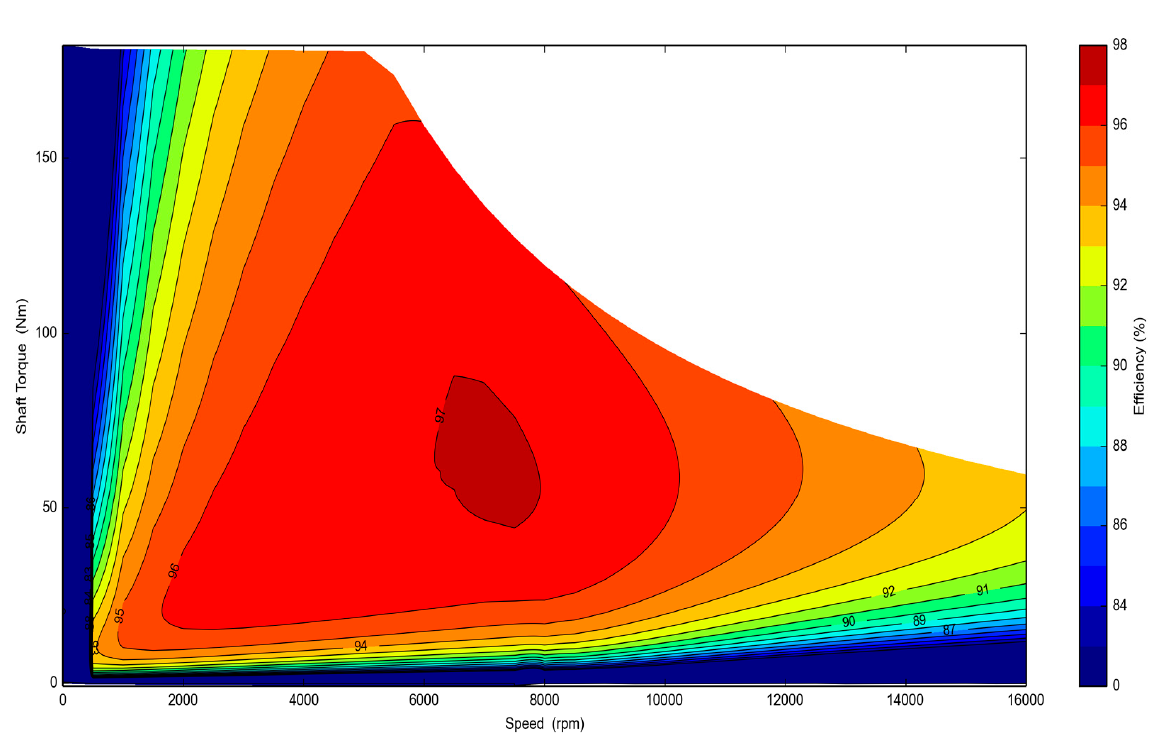
Figure 11. Efficiency map of V-shaped